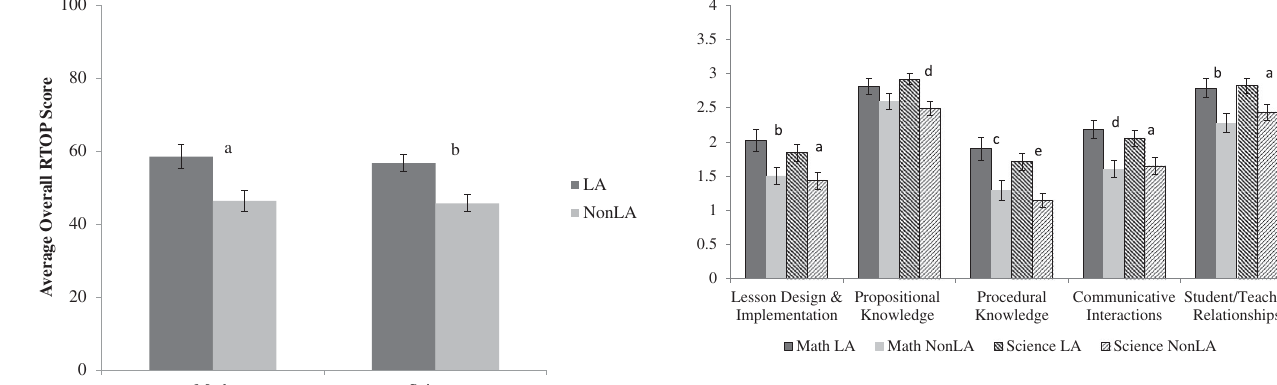
FIG. 2. Average statement response for the five categories of the RTOP. Error bars represent plus and minus 1 standard error on the mean. (a) p ¼ 0 . 02 , (b) p ¼ 0 . 01 , (c) p ¼ 0 . 005 , (d) p ¼ 0 . 001 , (e) p ¼ 0 . 001 , and (f) p ¼ 0 . 0003